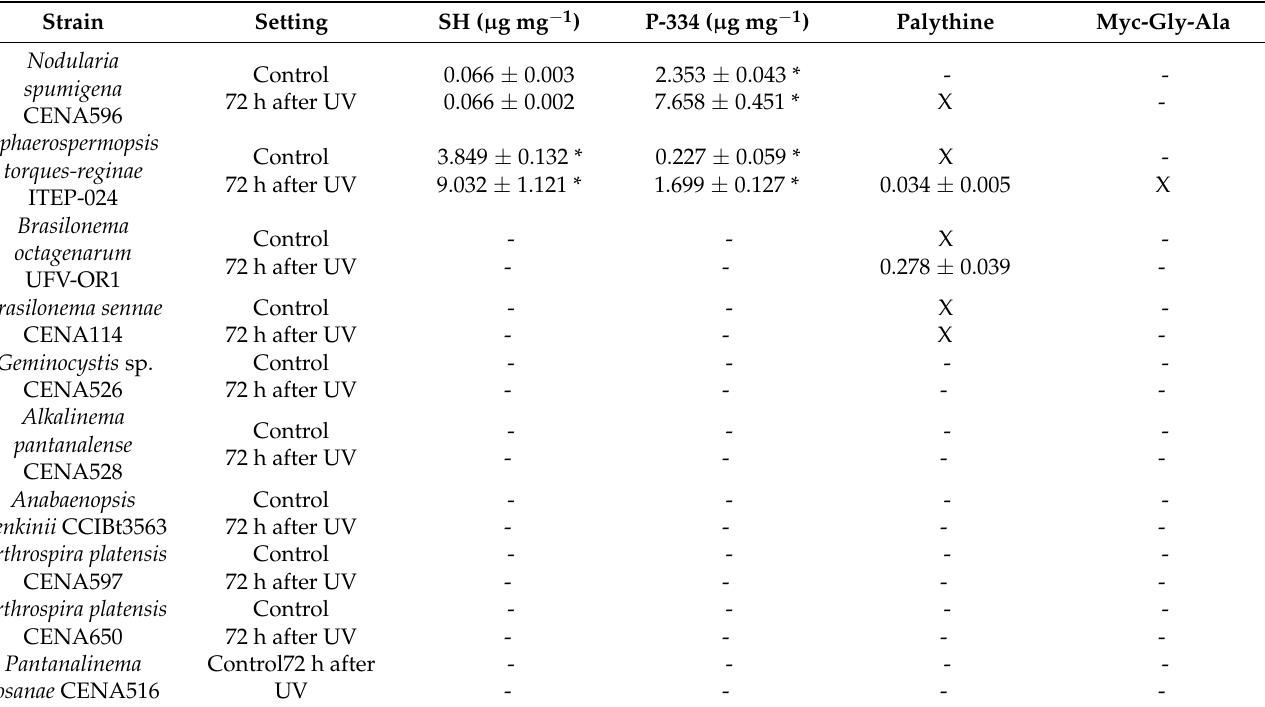
Table 2. Concentrations of shinorine (SHI) and porphyra-334 (P-334) detected in the cyanobacteria studied according to the UV irradiance